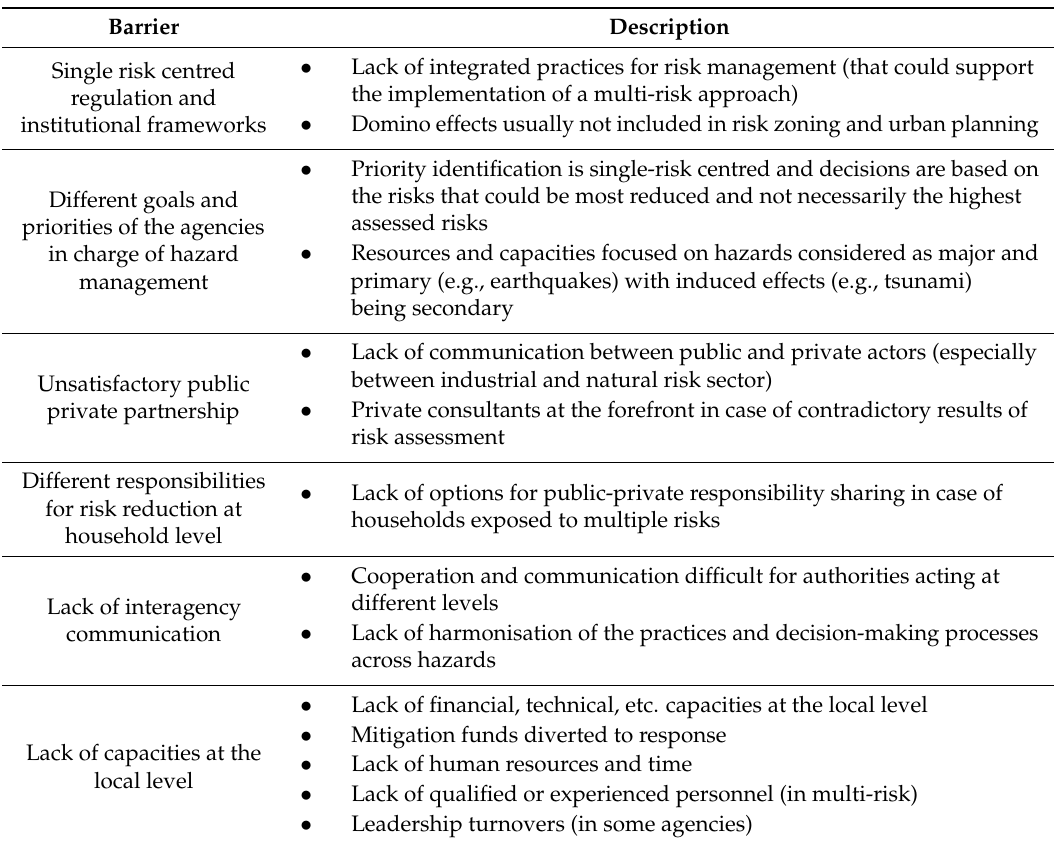
Table 3. Institutional barriers to the implementation of multi-risk